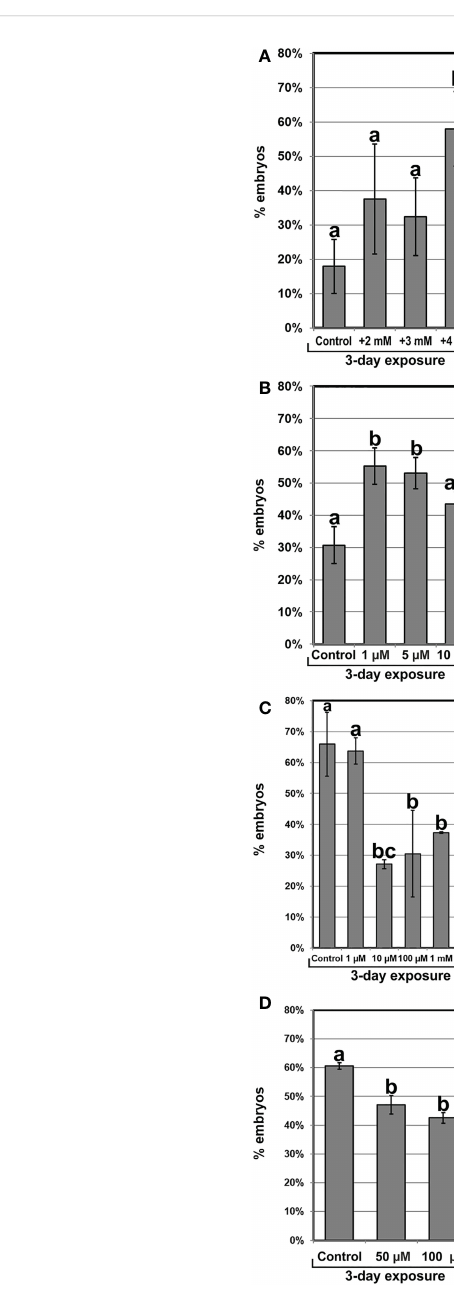
FIGURE 5 Modulation of intracellular Ca 2+ homeostasis by the addition of CaCl 2 (A) , the Ca 2+ channel ionophore A23187 (B) , EGTA, a Ca 2+ chelator (C) , and W-7, a CaM antagonist (D) at different concentrations and 3-day, 7-day and continuous exposures. The effects of the treatments are expressed as percentages of embryos produced (% embryos) ± standard error. At least three different repeats were performed for each chemical, concentration and exposure time applied. Data were analyzed using the ANOVA test and groups of signi fi cance were established according to the least signi fi cant difference (LSD) test (p ≤ 0.05). Different letters represent signi fi cant differences with respect to their respective controls according to the LSD